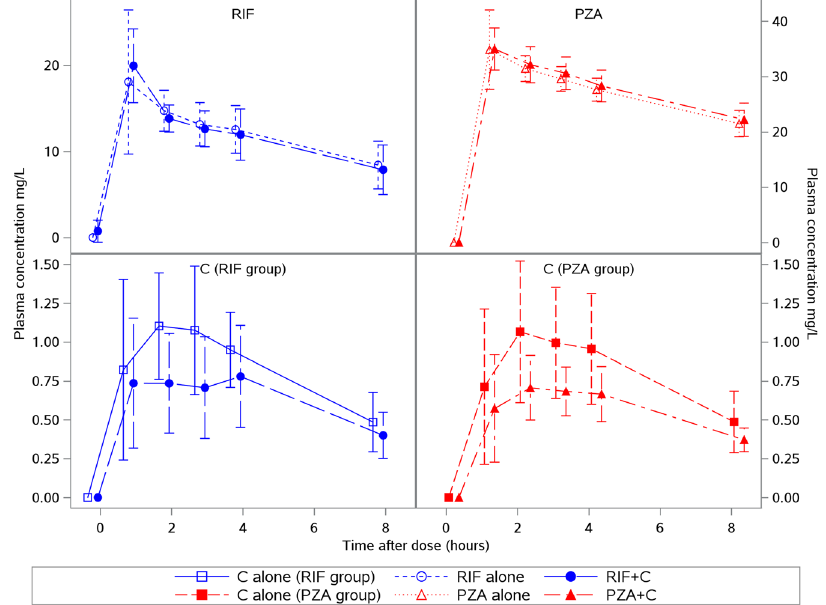
Figure 1. Plasma drug concentration of rifampicin (upper left panel), pyrazinamide (upper right panel), celecoxib in the RIF group (lower left panel), and celecoxib in the PZA group (lower right panel) at individual time-points up to 8 hours after dose. On each panel plots of plasma concentration are separate for two study visits where a drug or its combination with another drug is administered. Abbreviations: C, celecoxib; RIF, rifampicin; PZA, pyrazinamide.